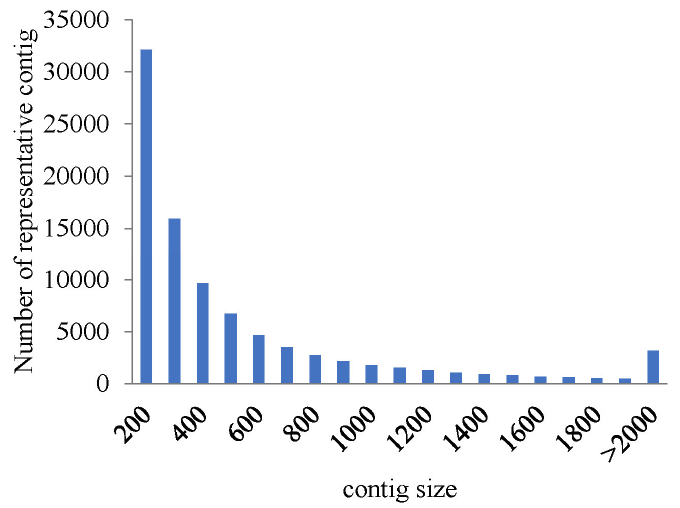
Figure 2. The length distribution of representative contigs in the sequenced cDNA library.